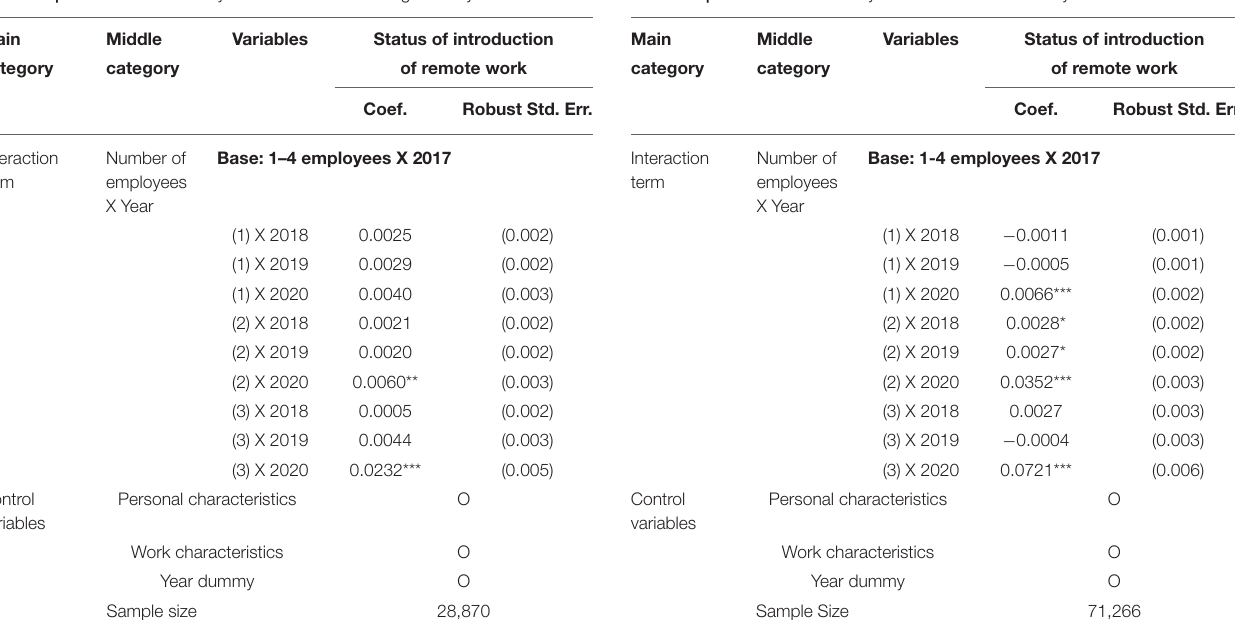
TABLE 5 | Interaction term analysis for the manufacturing industry. TABLE 6 | Interaction term analysis for the service